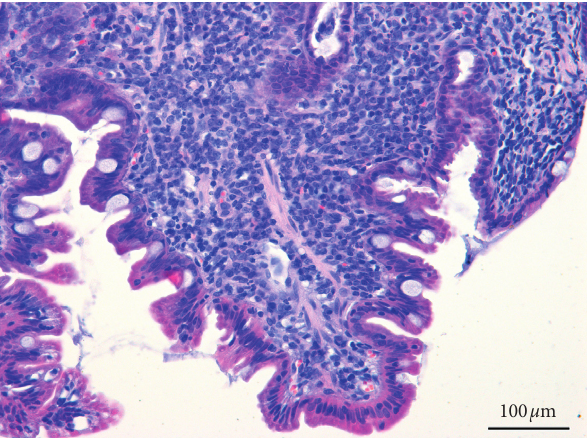
Figure 3: The microscopic view of infiltration of inflammatory cells observed in alimentary lymphoma in